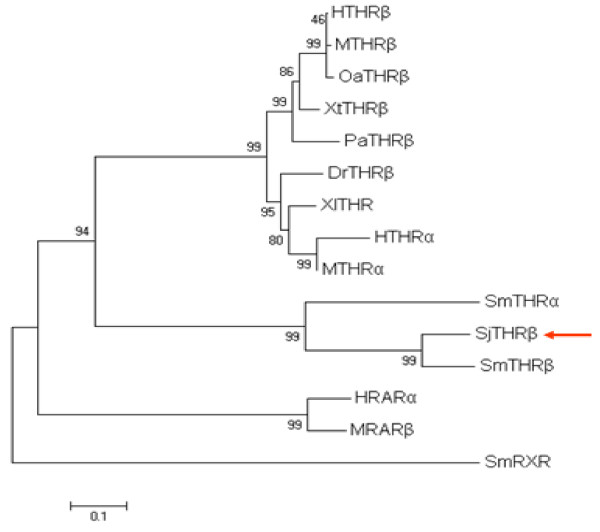
Phylogenetic analysis of SjTHRβ. The phylogenetic tree derived from 15 protein sequences was constructed by the Cluster W program and plotted with MEGA4. The Genbank accession numbers used in the analysis were: HTHRβ, Homo sapiens, NP_001121649.1; MTHRβ, Mus musculus, AAI19554.1; OaTHRβ, Ovis aries, NP_001177320.1; XtTHRβ, Xenopus (Silurana) tropicalis, NP_001039270.1; PaTHRβ, Pseudopleuronectes americanus, AAV66918.1; DrTHa, Danio rerio, NP_571471.1; XlTHR, Xenopus laevis, AAA49969.1; HTHRα, Homo sapiens, NP_001177848.1; MTHRα, Mus musculus, NP_835161.1; SmTHRα, Schistosoma mansoni, XP_002573733.1; SmTHRβ, Schistosoma mansoni, AAR29359.1; SjTHRβ, Schistosoma japonicum, HRARa, Homo sapiens, P10276; MRARb, Mus musculus, P22605; SmRXR, schistosoma mansoni, AF094759.